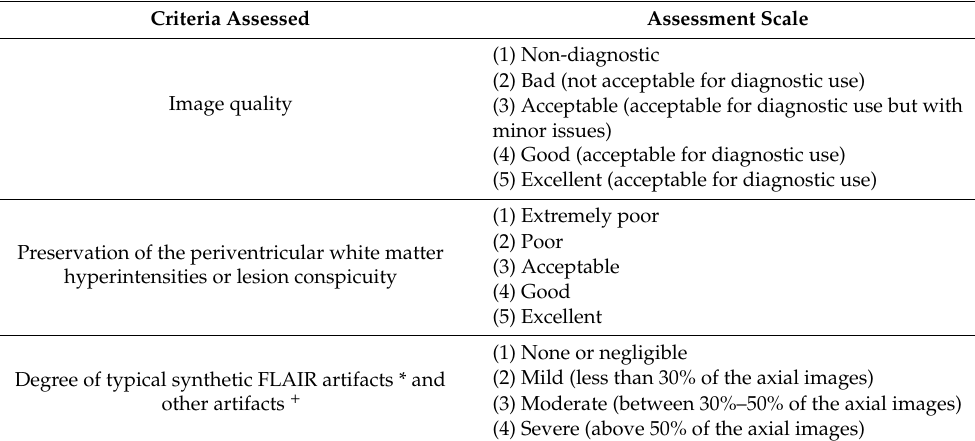
Table 1. Assessment criteria for qualitative analysis using the Likert scale.